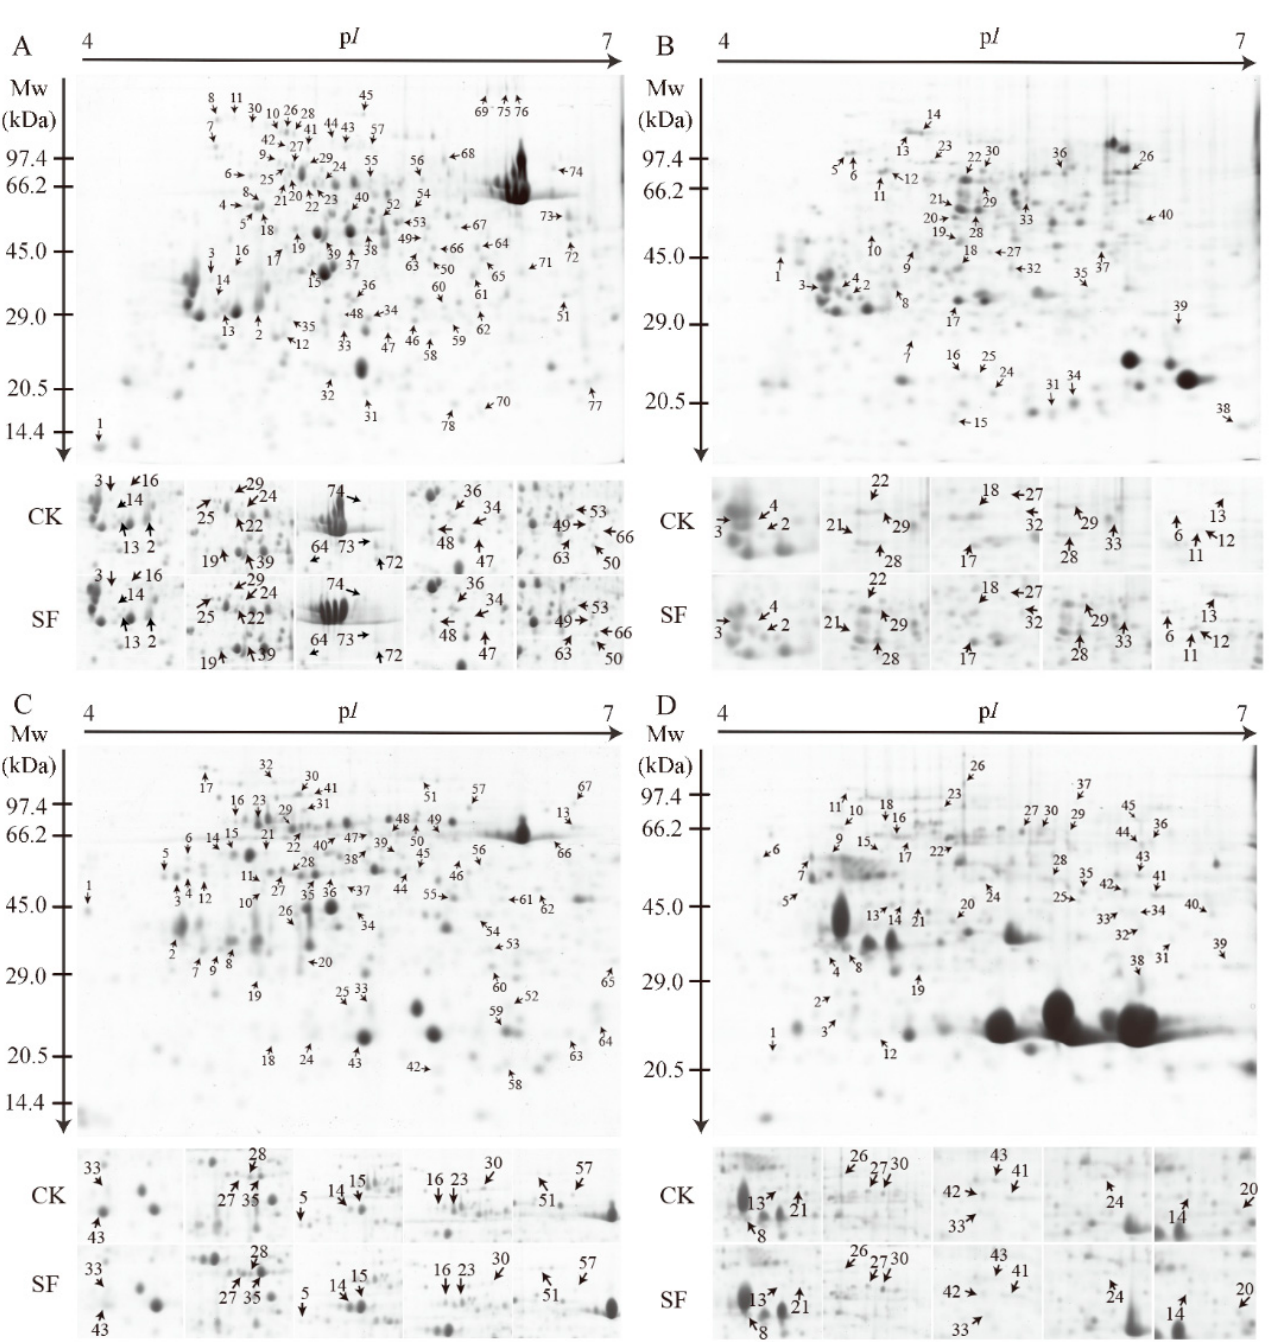
Figure 3. Two-dimensional (2-DE) analysis of proteins extracted from ( A ) A. ilicifolius leaves, ( B ) A. ilicifolius roots, ( C ) A. mollis leaves, and ( D ) A. ilicifolius roots. The numbers correspond with the spot ID, mentioned in Supplementary Tables S2–S5. The isoelectric point (p I ) and molecular weight (MW) in kilodaltons are indicated on the top and left of the gel, respectively. CK and SF represent the control group and soil tidal flooding stress, respectively.